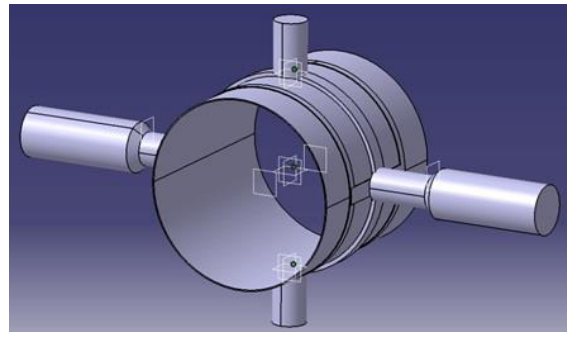
Fig. 4. Design of the oil film 3